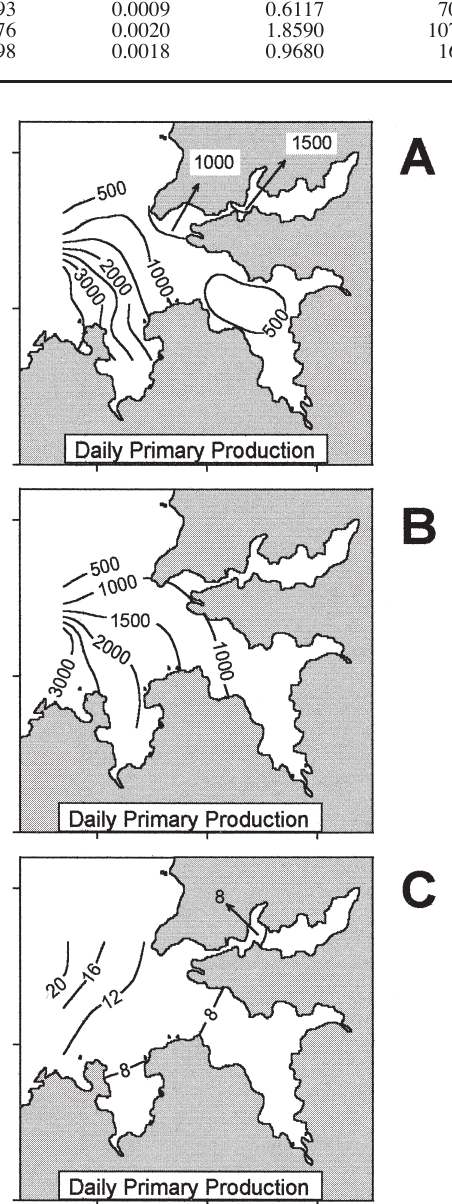
F IG . 6. – Spatial distribution of values of water-column integrated primary production (mg C m -2 d -1 ) in the study area during the cruises COPLA-393 (A), COPLA-893 (B) and COPLA-1293